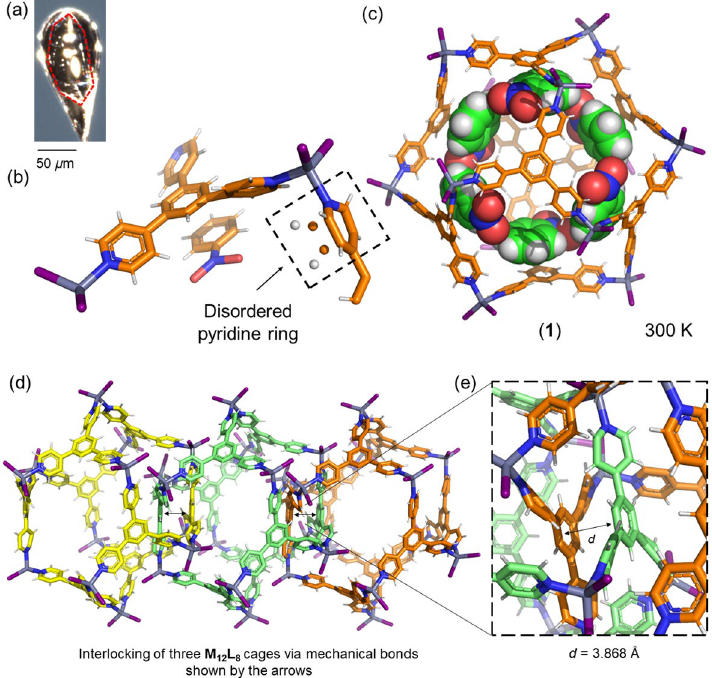
Figure 3. ( a ) A photo of a single crystal that was used for SC-XRD structure solution of 1 . ( b ) Asymmetric unit content showing the disordered pyridine ring and the included guest nitrobenzene. ( c ) Assembly of the M 12 L 8 nanocage including the six ordered guest molecules having good electrostatic interactions with the cage. Color code host: Carbon: orange; Nitrogen: blue; Hydrogen: white; Zinc: gray; Iodide: Purple. Color code guest: Carbon: green; Nitrogen: blue; Hydrogen: white; Oxygen: red. ( d ) View of three M 12 L 8 nanocages linked by the mechanical bond. ( e ) Expanded view displaying the aromatic-aromatic distance among TPB ligands in the interlocked cages. To show the three different M 12 L 8 nanocages, the Carbon atoms are yellow, green and